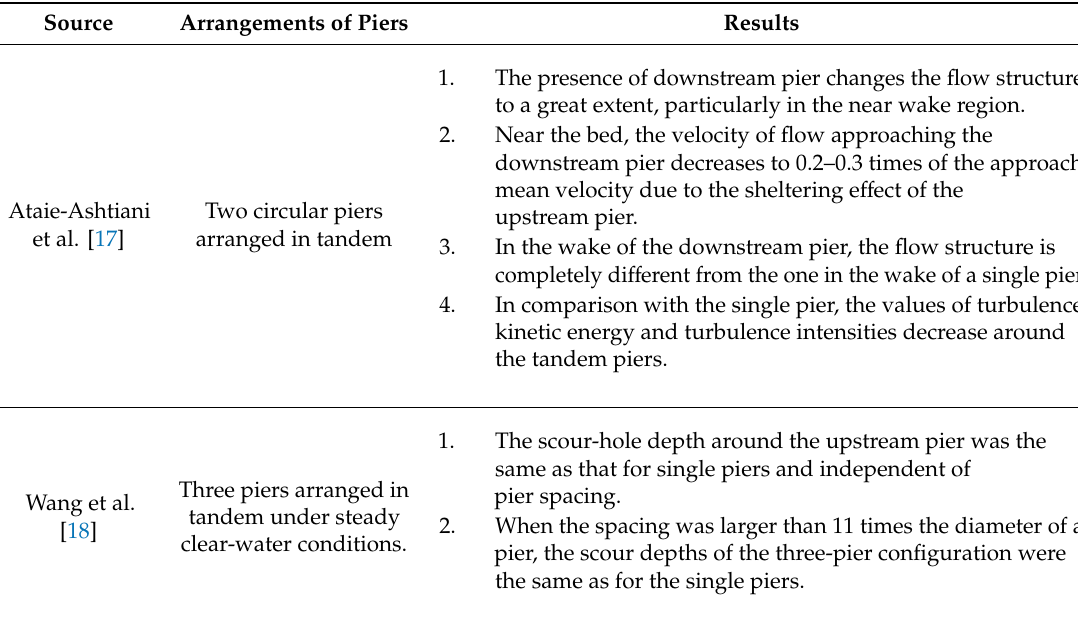
Table 1. Relevant research results of the flow field characteristics around tandem